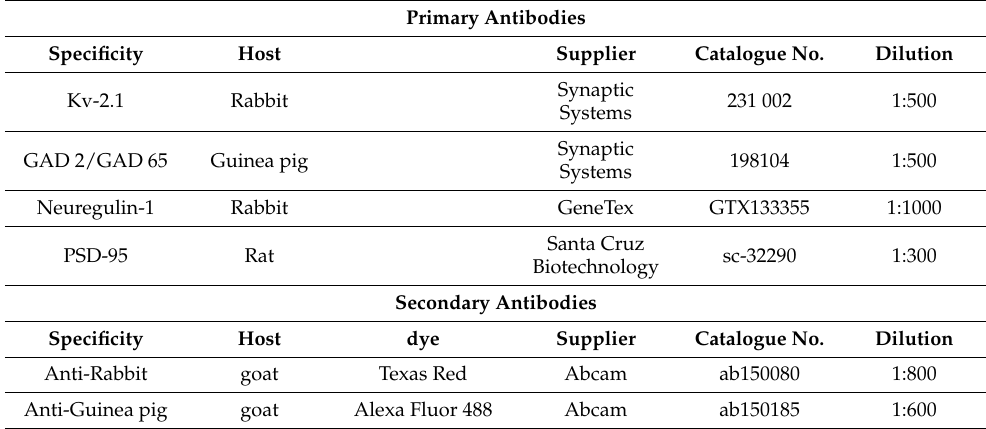
Table 1. Antibodies used in this